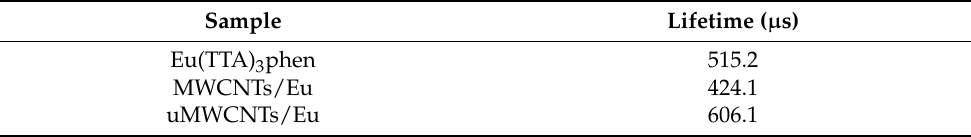
Figure 5. The excitation ( a ) and emission ( b ) spectra of MWCNTs/Eu and uMWCNTs/Eu and luminescence decay curves ( c ) of MWCNTs/Eu, uMWCNTs/Eu and Eu(TTA) 3 phen. Table 2. Luminescence lifetimes of MWCNTs/Eu, uMWCNTs/Eu and Eu(TTA) 3 phen.